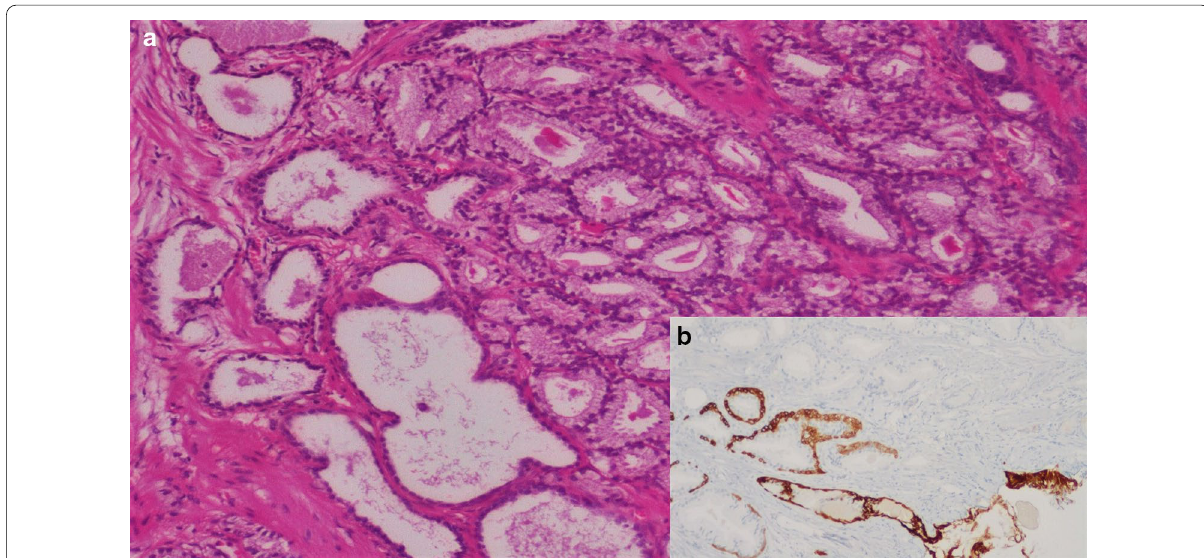
Fig. 1 a Focus of incidental prostate cancer—well-formed, small to medium sized infiltrative glands (hematoxylin and eosin, HMWCK expression in prostate cancer focus (immunohistochemistry,